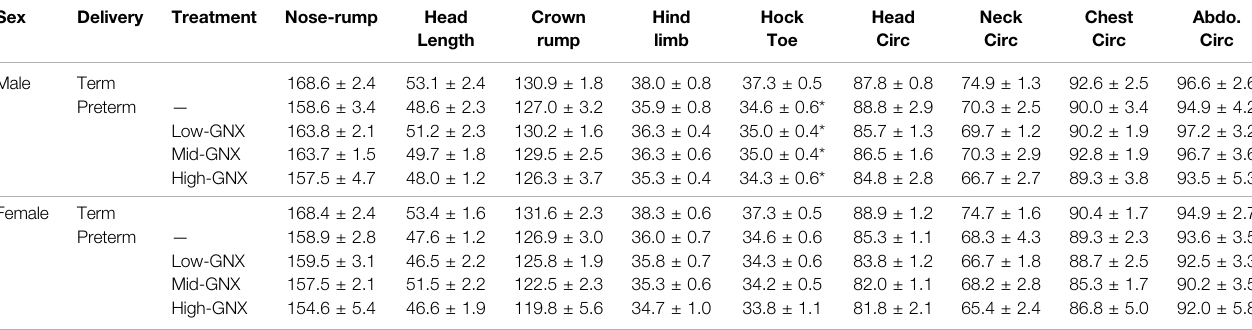
TABLE 4 | Body measurements at term